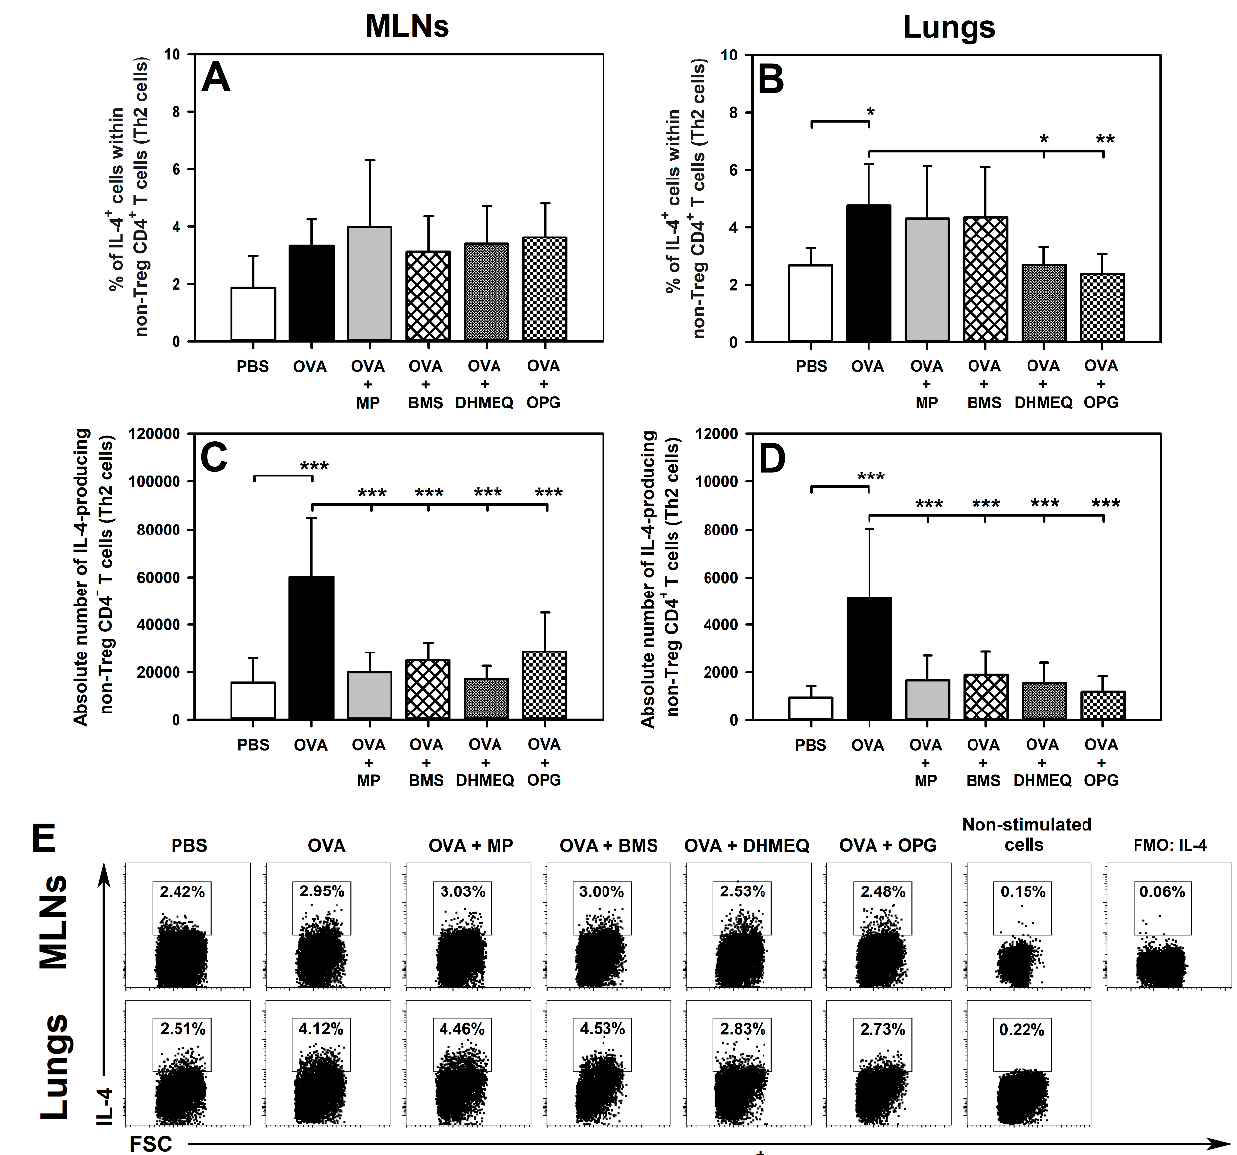
Figure 1. Effect of inhibitors of IKK (BMS-345541 (BMS)), NF- κ B translocation (dehydroxymethylepoxyquinomicin (DHMEQ)) and RANK/RANK-L interaction (osteoprotegerin (OPG)), and glucocorticosteroid (methylprednisolone (MP)) administration on the number of IL-4-producing non-Treg CD4 + T cells. The relative count ( A , B ) is expressed as a per- centage of IL-4-producing cells within non-Foxp3 + CD25 + CD4 + T cells. The absolute count ( C , D ) represents the number of IL-4-producing non-Foxp3 + CD25 + CD4 + T cells per MLN or lung sample collected from individual mice. * p < 0.05, ** p < 0.01, *** p < 0.001. Examples of dot plot cytograms showing the distribution of IL-4-producing and non-producing cells within non-Treg CD4 + T cells ( E